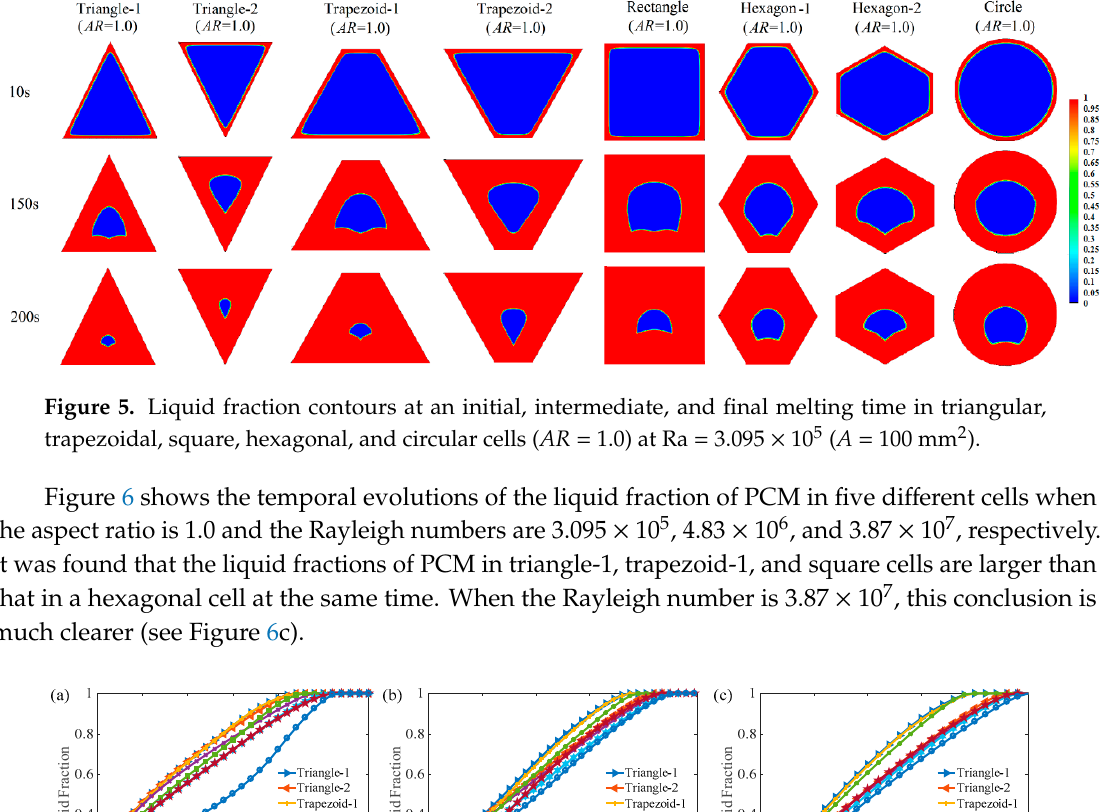
Figure 5. Liquid fraction contours at an initial, intermediate, and final melting time in triangular, trapezoidal, square, hexagonal, and circular cells ( AR = 1.0) at Ra = 3.095 × 10 5 ( A = 100 mm 2 ) .